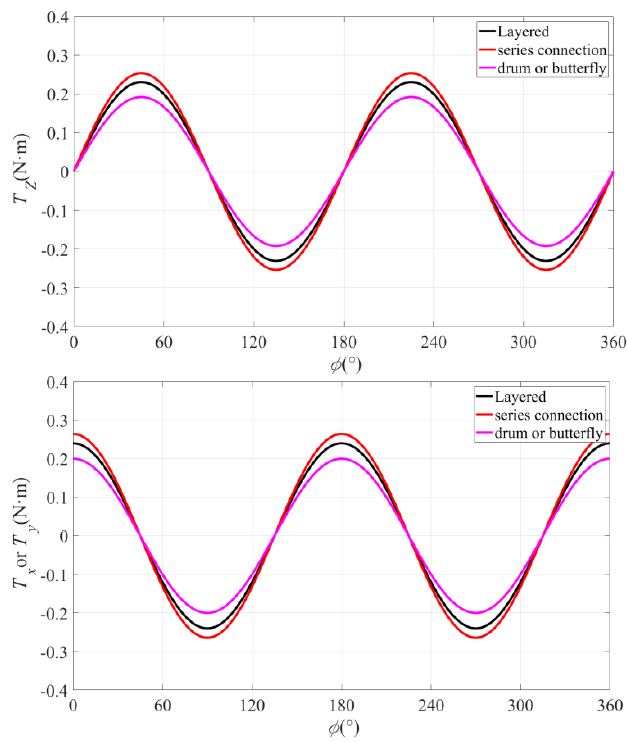
Figure 15. Torque curves comparison with di ff erent structures.